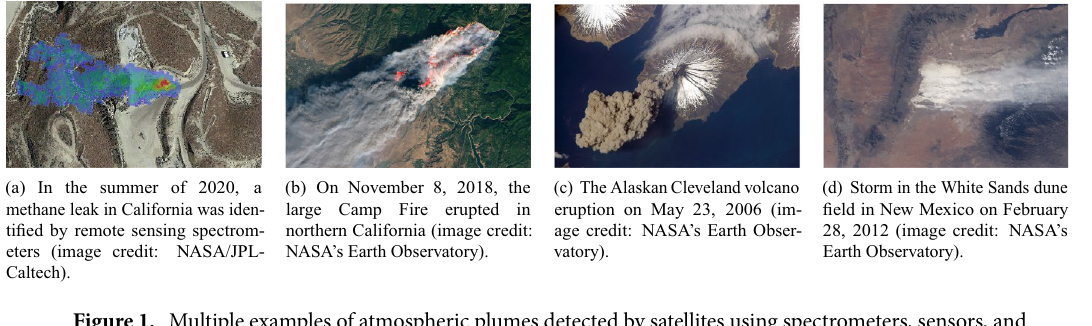
Figure 1. Multiple examples of atmospheric plumes detected by satellites using spectrometers, sensors, and